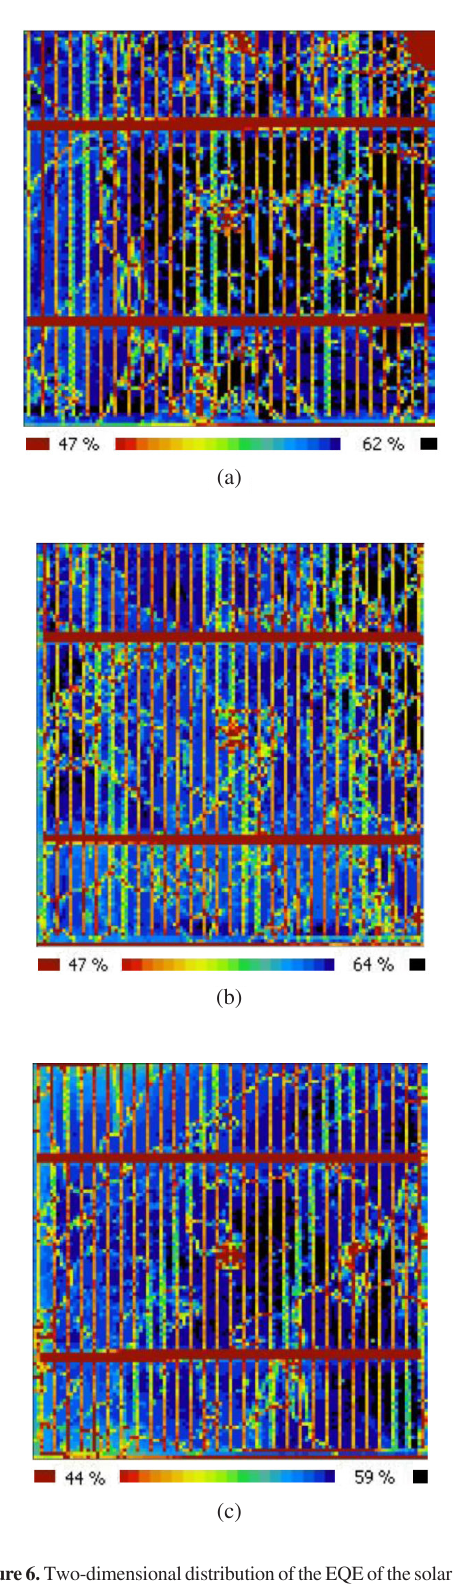
Figure 6. Two-dimensional distribution of the EQE of the solar cells (a) Cel-PT3 (n + pp + ), (b) Cel-PT10 (n + pp + ) and c) Cel-NT21 (n + pn +